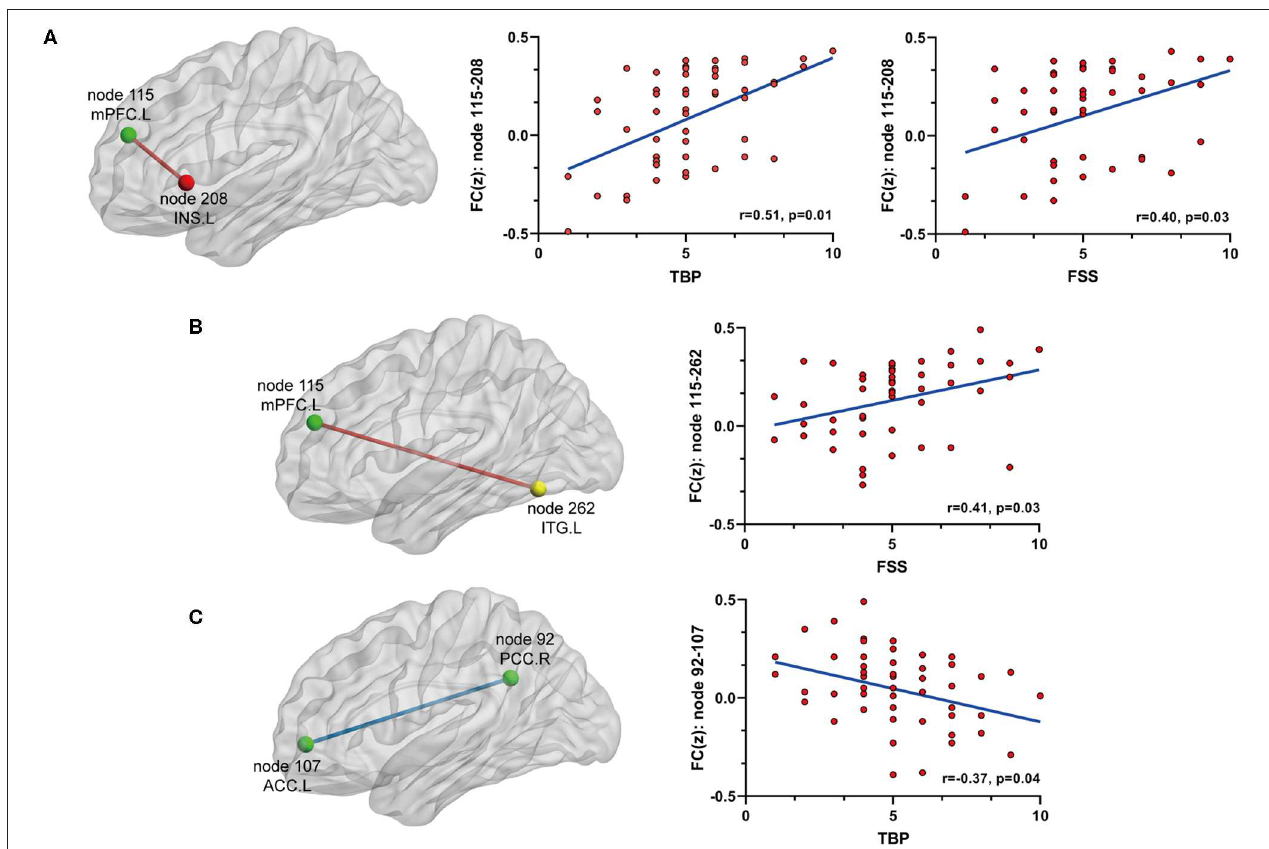
FIGURE 2 | The relationship between significant FC and pain or fatigue as measured by TBP or FSS ( p < 0.05, Bonferroni corrected): (A) FC between node 115 (mPFC) and node 208 (INS.L) was positively[[Inline Image]] associated with both pain and fatigue; (B) FC between node 115 (mPFC) and node 262 (ITG.L) was positively associated with fatigue; (C) FC between node 92 (PCC.R) and node 107 (ACC.L) was negatively associated with fatigue. mPFC, medial prefrontal cortex; INS.L, left insula; ITG.L, left inferior temporal cortex; PCC.R, right posterior cingulate cortex; ACC.L, left anterior cingulate